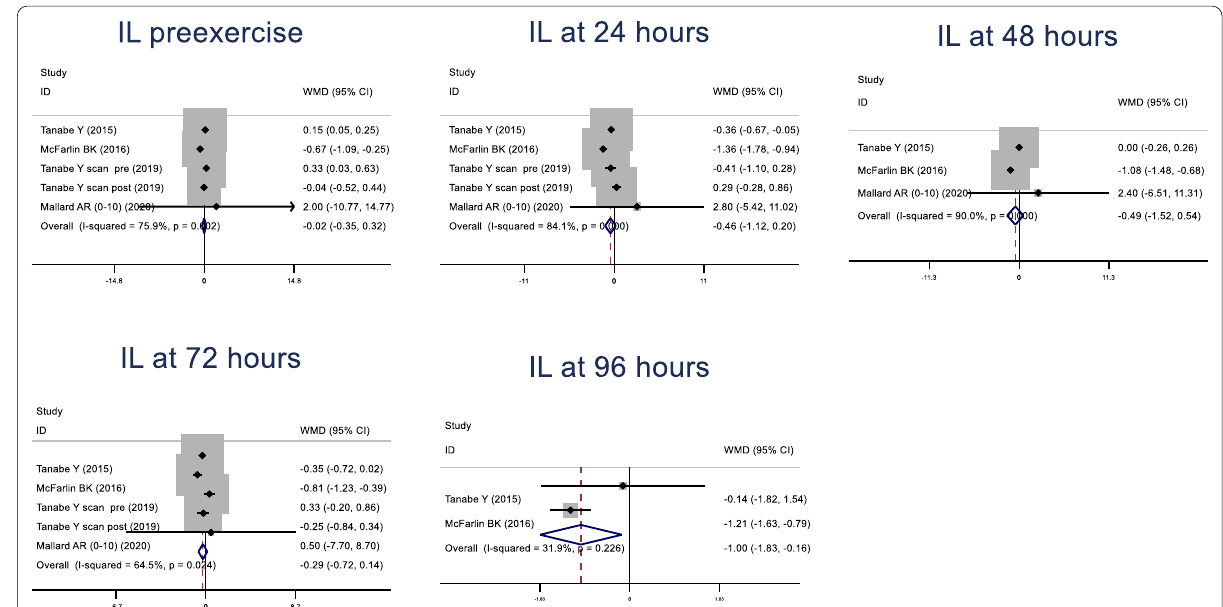
Fig. 5 Forest plot for comparison of IL score at pre-, 24, 48, 72 and 96 h after exercise between curcumin supplement versus placebo